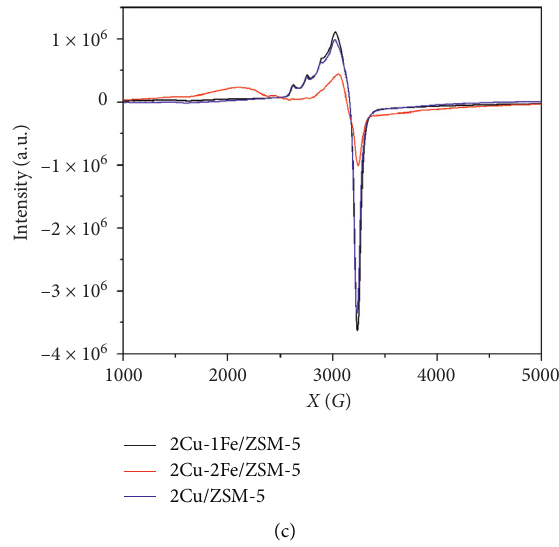
Figure 8: EPR spectra of series catalysts measured at -173 ° C of (a) Cu/ZSM-5, (b) Fe/ZSM-5, and (c)